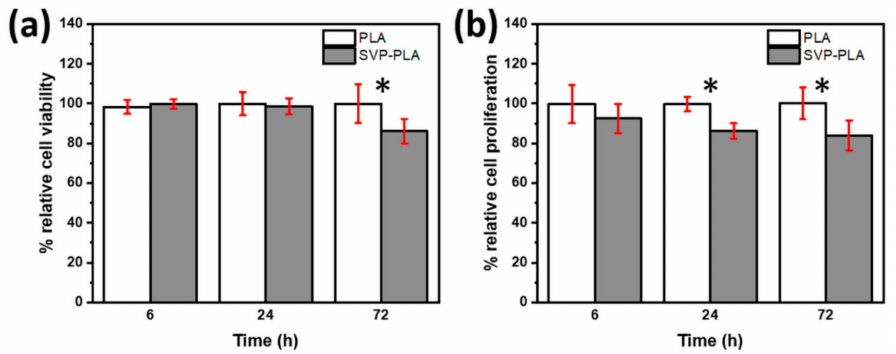
Figure 4. ( a ) MTT and ( b ) BrdU assay of human osteosarcoma (SaOS-2) cells (* represents the statistical significance between